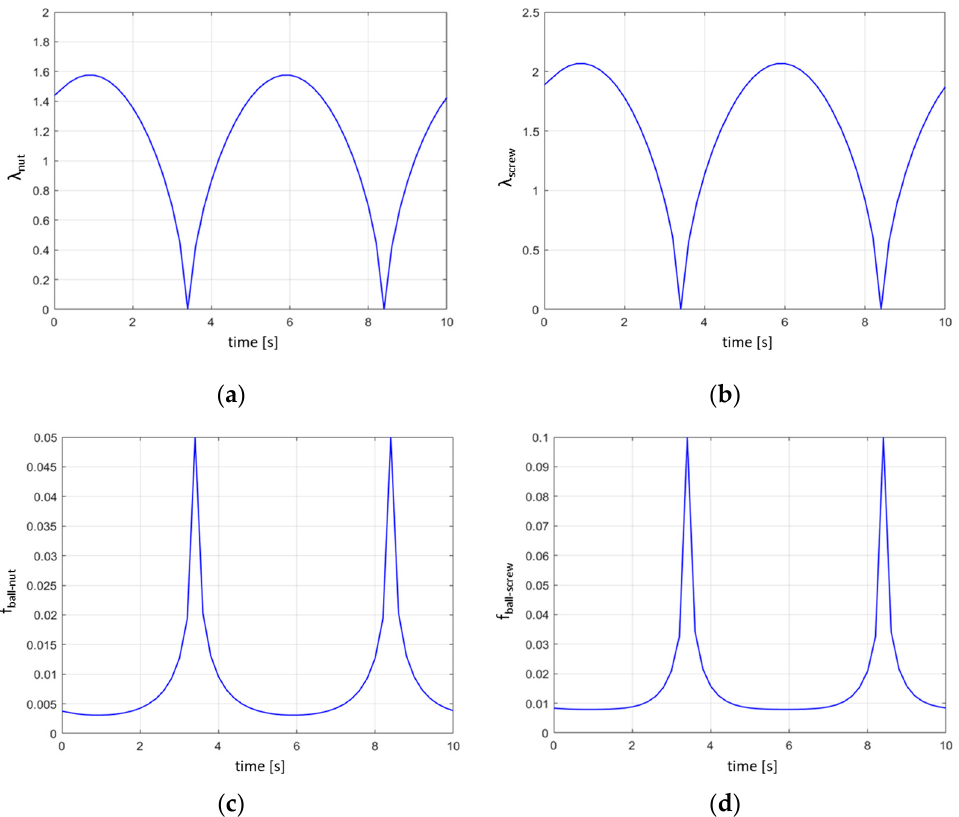
Figure 14. EHL model outputs as functions of time: ( a ) film parameter λ nut ; ( b ) film parameter λ screw ; ( c ) coefficient of friction f ball-nut ; ( d ) coefficient of friction f ball-screw . Finally, indirect efficiency η is reported below in Figure 15.